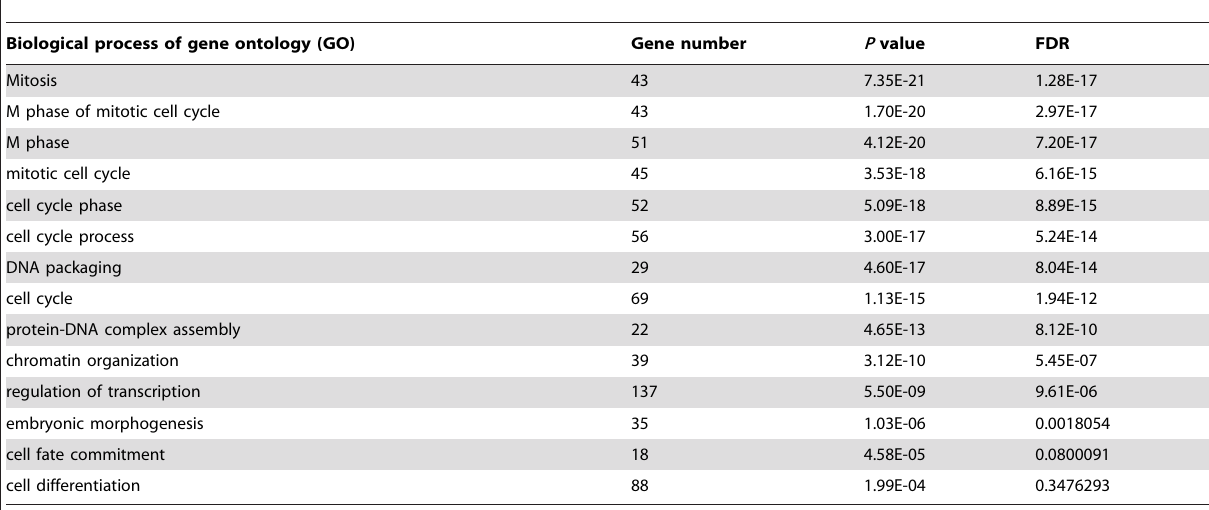
Table 4. Significantly enriched biological processes and pathways among the informative B-MYB target genes identified from CHiP-chip and